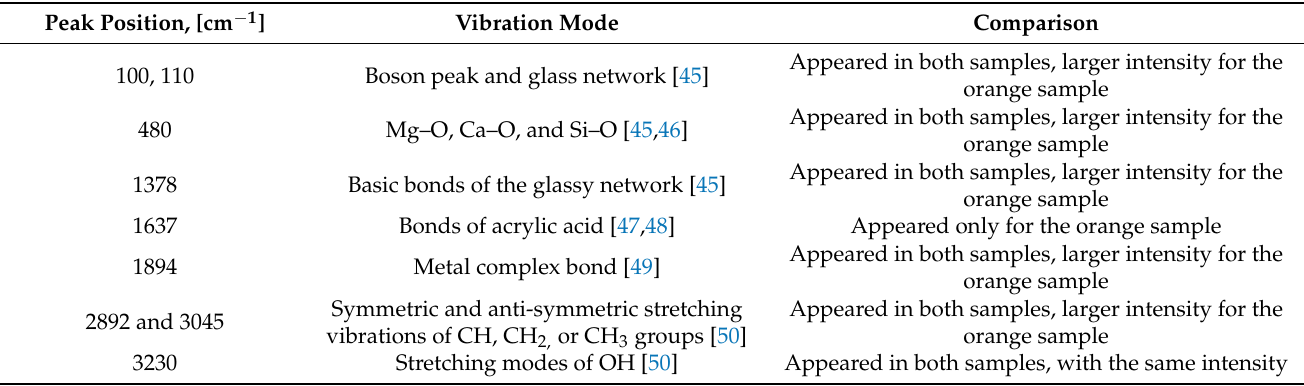
Table 6. Identification of the signs in Raman